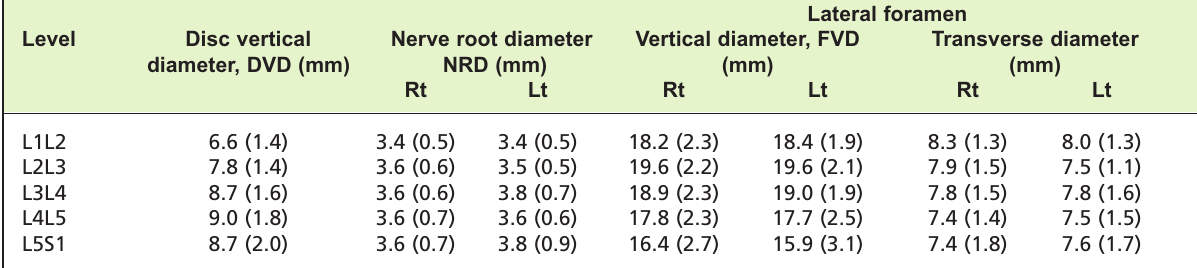
Mean disc vertical diameter, nerve root diameter, foraminal vertical diameter and transverse diameter of the 62 Table I: studied patients based on MRI measurement